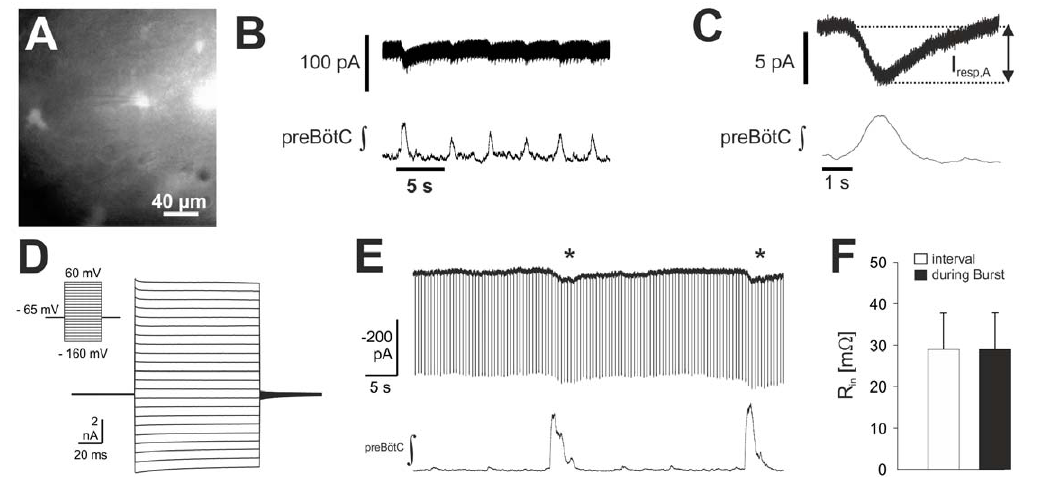
Figure 1. Rhythmic inward currents in astrocytes of the pre-Bo¨tzinger Complex (preBo¨tC). ( A ) To identify astrocytes a CCD-image was taken and the astrocyte, identified by its (green) fluorescence in the center of the image was whole-cell recorded in voltage-clamp mode showing ( B ) respiratory-rhythmic inward currents that were partly obscured by the noise (V hold =-70 mV; upper trace). The integrated preBo¨tC-field potential (preBo¨tC 8 ), recorded in parallel, is shown in the lower trace. (C) Cycle triggered averaging of inward currents was performed, using preBo¨tC-field potentials as triggers to allow the measurement of the amplitude of the respiratory rhythmic current (I resp,A ). ( D–F ) Input resistance of the astrocytes remains unchanged during astrocytic inward currents: Panels ( D ) and ( E ) show whole-cell recordings taken from a fluorescent preBo¨tC astrocyte. ( D ) Current traces recorded in response to the voltage step protocol, show in the insert, identified this astrocyte as passive. ( E ) In the presence of bicuculline (20 m M), large amplitude preBo¨tC field potentials were accompanied by large inward currents (asterisks) in the astrocytes (D). Hyperpolarizing voltage steps ( 2 10 mV) were applied to the astrocyte to measure membrane input resistance (R in ), which did not change in association with inward current transients ( F ; n=3).